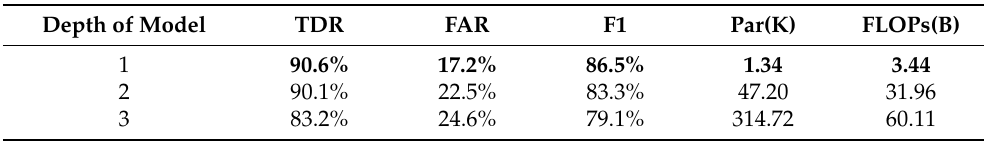
Table 2. Influence of autoencoder model depth, “Par” represents the model parameter quantity, “FLOPs” represents floating point